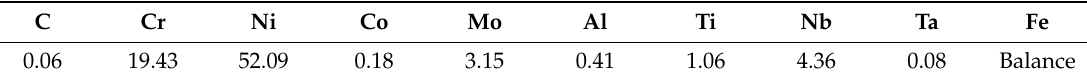
Table 1. Composition of the experimental superalloy (mass percent,